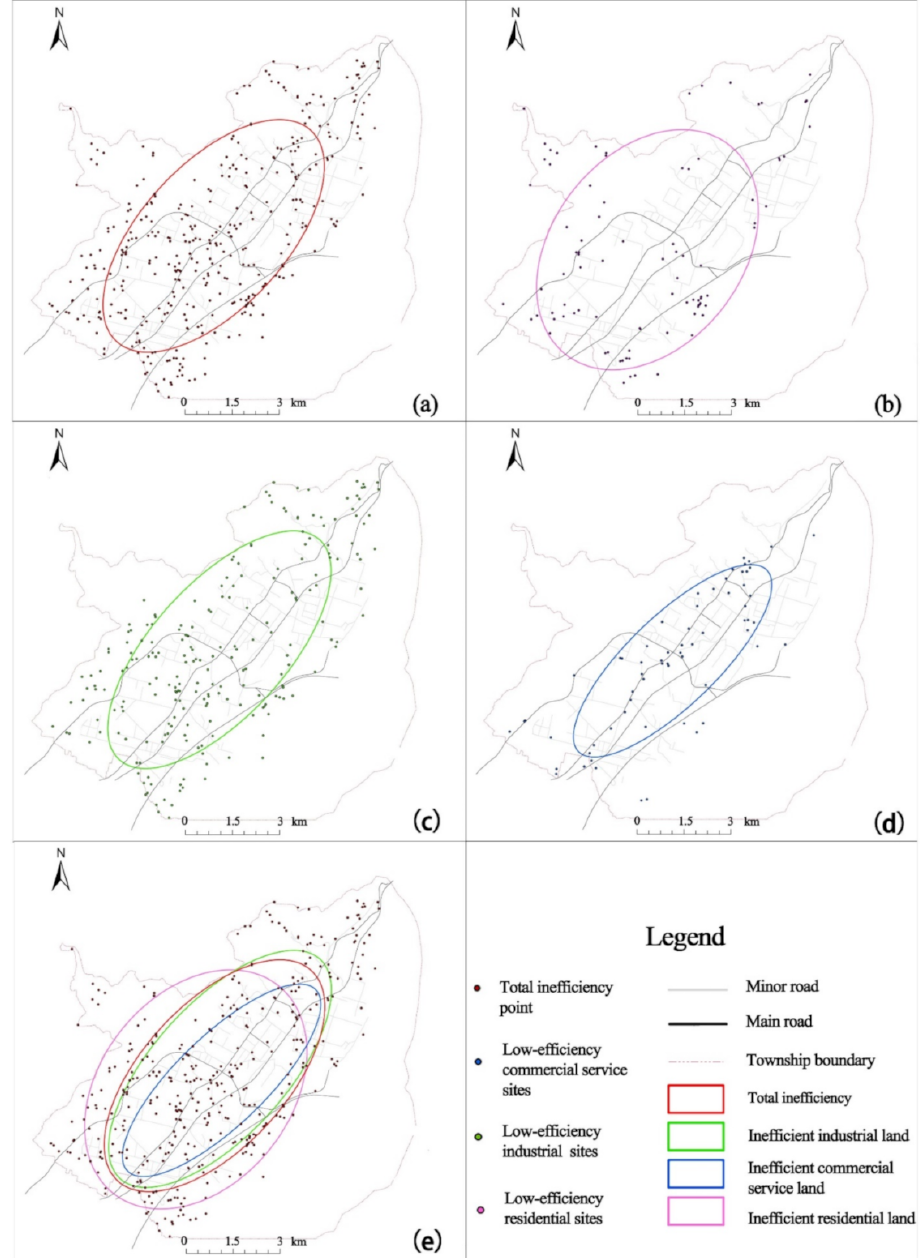
Figure 5. Standard deviation ellipse of the distribution of inefficient land use sites in Longmen Town. (( a ). Inefficient land; ( b ). Inefficient residential land; ( c ). Inefficient industrial land; ( d ). Inefficient commercial land; ( e ). Overall